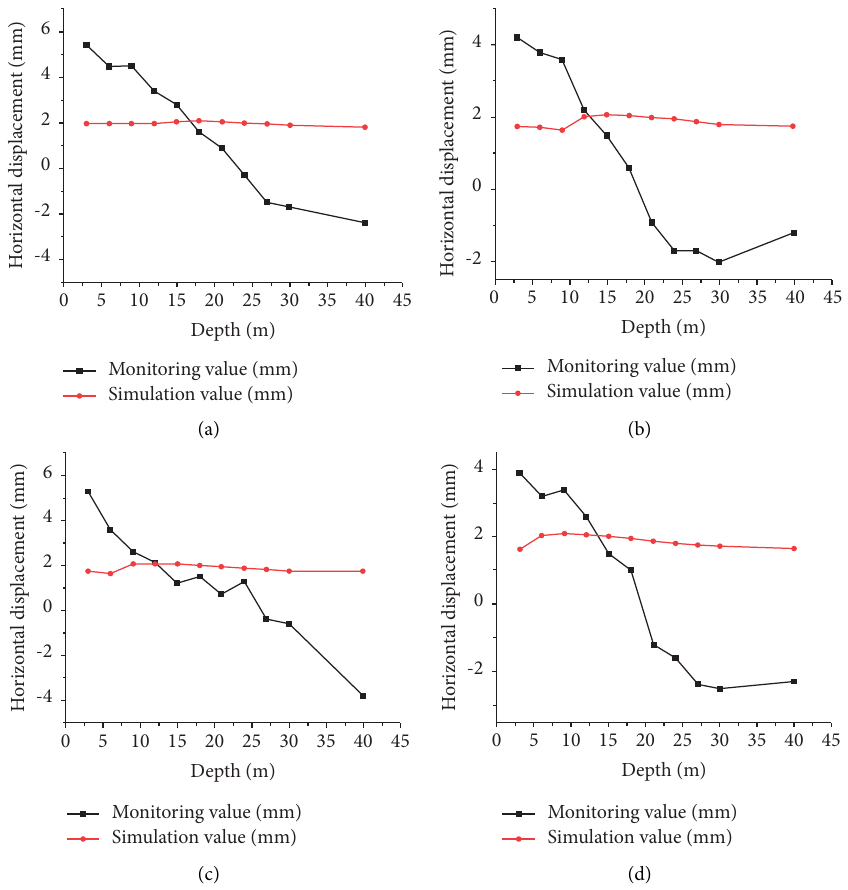
Figure 8: Parameter verifcation of working condition 3. (a) No. 2 section ( P � 0.63106). (b) No.15 section ( P � 0.144479). (c) No. 28 section ( P � 0.376336). (d) No. 42 section ( P �